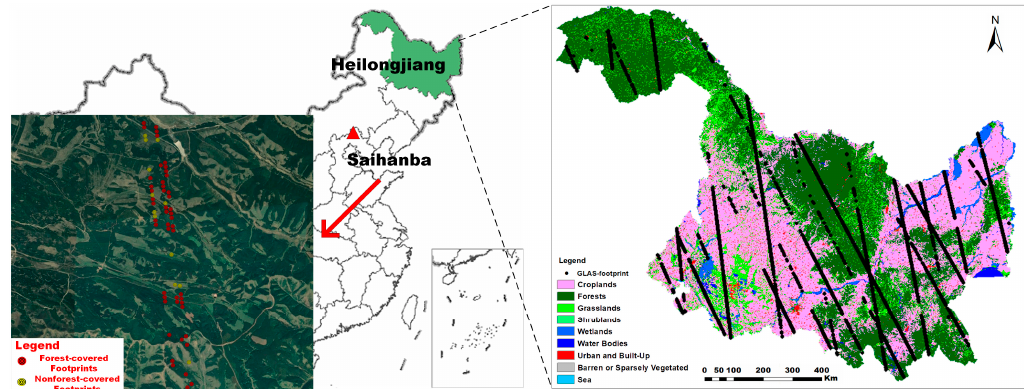
Figure 1. Geoscience Laser Altimeter System (GLAS) footprints distribution in study areas of Saihanba National Forest Park and Heilongjiang Province. The base map of Saihamba National Forest Park is the high-resolution image extracted from Google Maps. The base map of Heilongjiang Province is the ground surface landcover image provided by the GlobeLand30 landcover product. Table 1. Key information extracted from GLAS